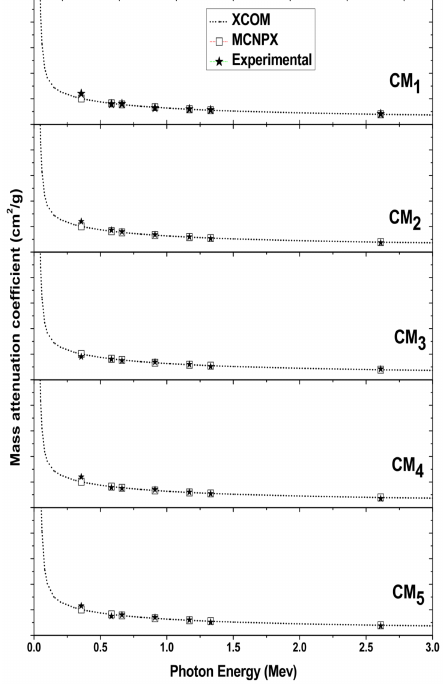
Figure 4: The measured mass attenuation coefficient compared with that determined by MCNPX and WinX-